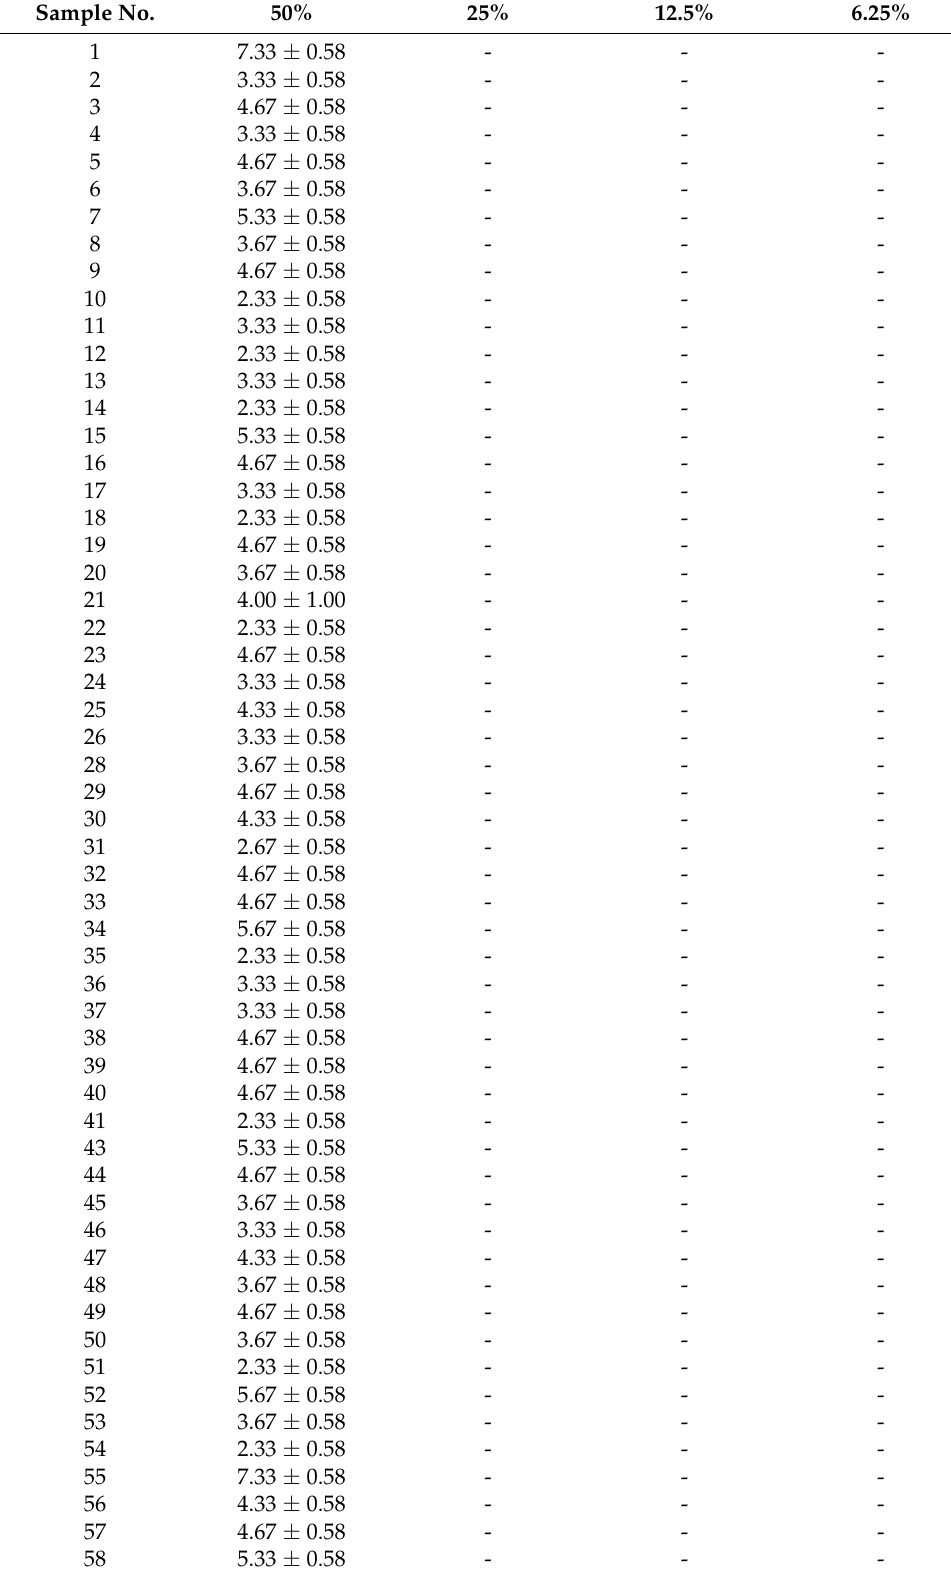
Table 10. Antimicrobial activity of samples against C. tropicalis in mm. Sample